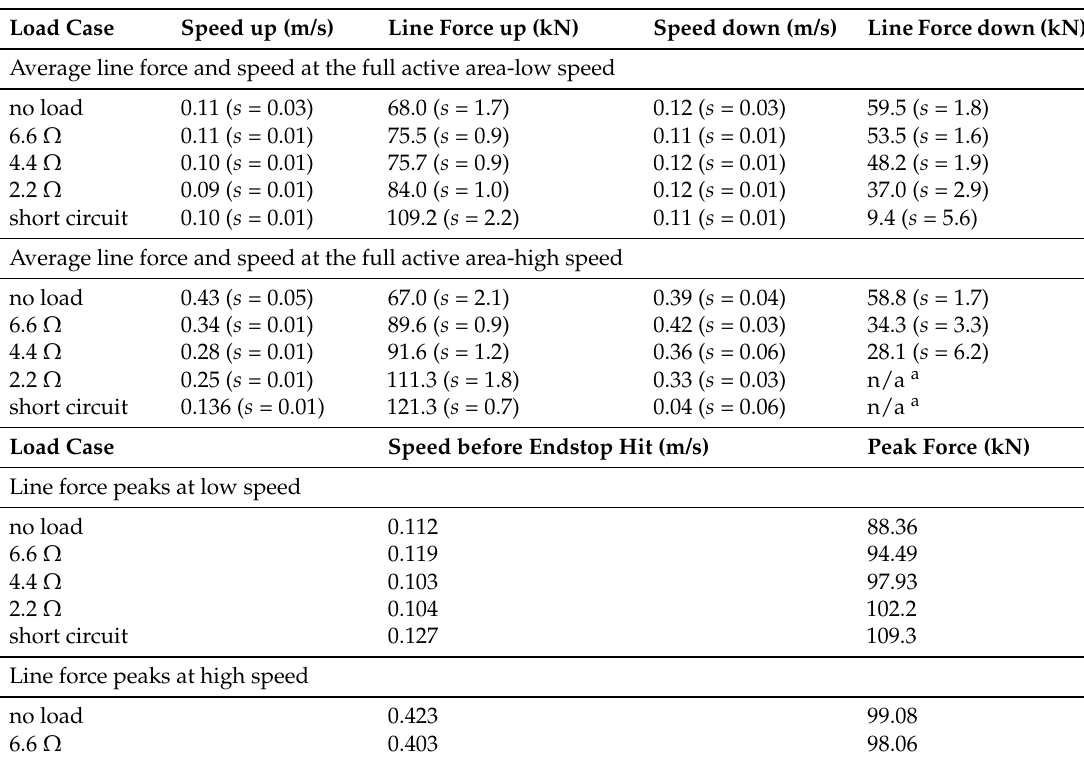
Table 4. Measured line force during the full active area and at upper endstop impact. The line force and speed during the full active area is presented with average value and standard deviation, s , for the data corresponding to the dotted boxes in Figures 2c, 3c and